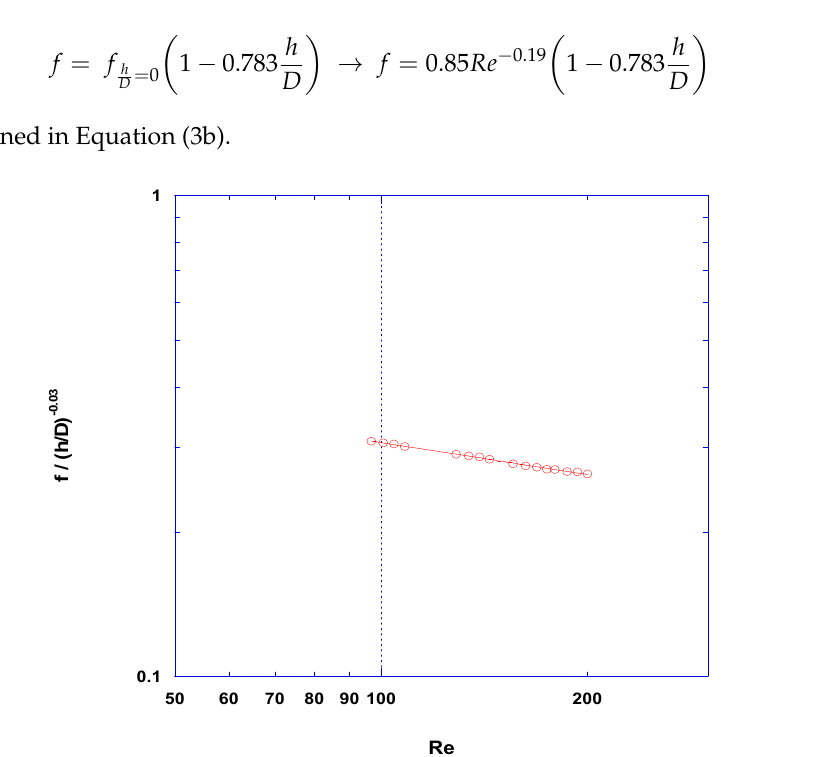
Figure A2. Dimensionless pressure drop (modified friction factor) as a function of the ratio h / D and Re number. Correlation: f = 0.85( h / D ) − 0.03 Re − 0.22 .